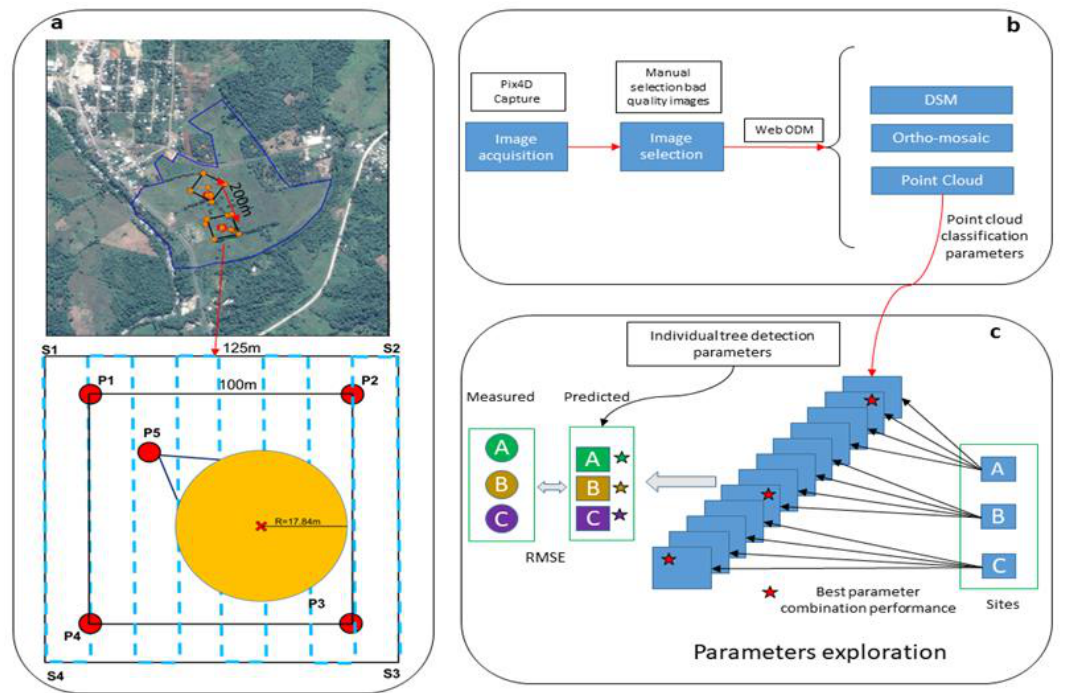
Figure 2. Workflow for the assessment of woody vegetation on livestock landscapes. ( a ) Example of plot location on farms, 1-hectare square plot (P1 – P4), circular plot field survey (P5), UAS flight mission (S1 – S4). ( b ) Processing pipeline for DSM, orthomosaic and point-cloud construction. ( c ) detection parameters for tree-characteristic measurements derived from UAS products.